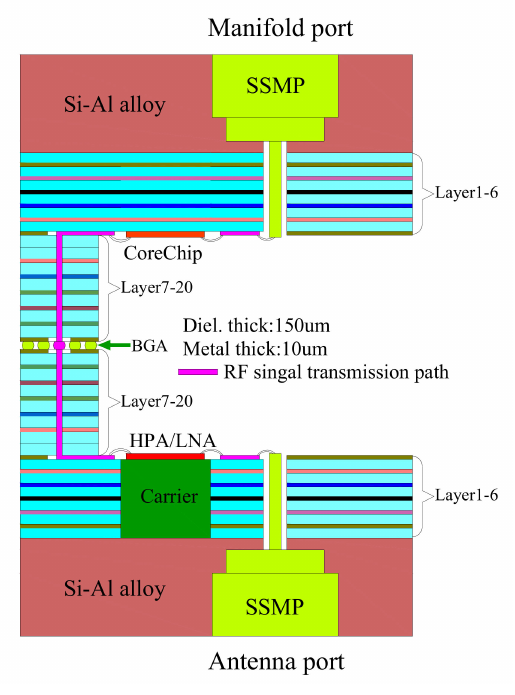
Figure 2. Complete stack-up of the two